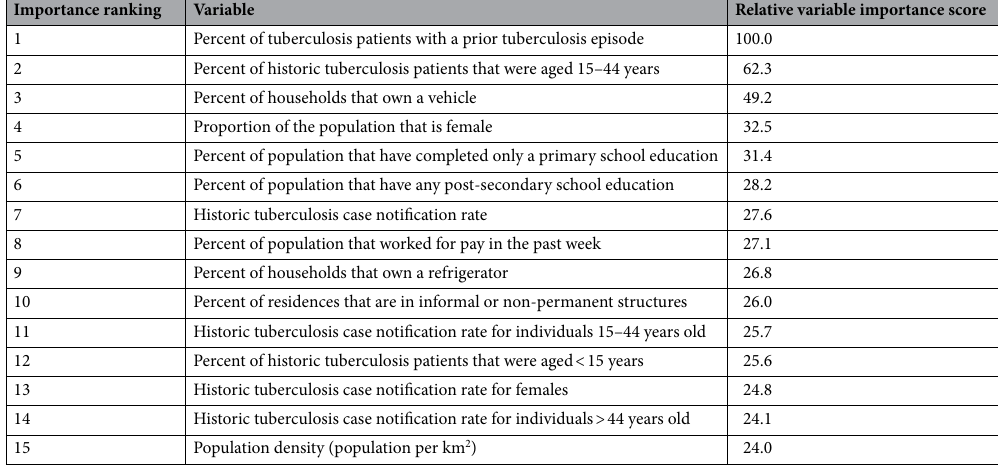
Table 4. Top 15 most important variables for predicting tuberculosis screening yield (Approach 2b, CART with categorical outcome; n = 73 neighborhoods).